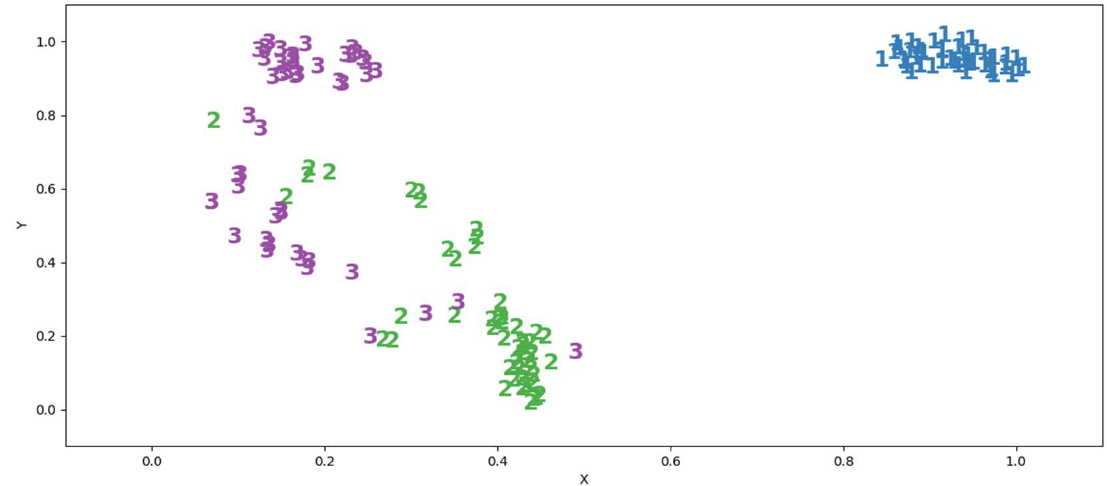
Figure 7. Fisher’s Irises training dataset (different classes colored differently for convenience). Table 5. SVM, VC and EnAE quality assessment by traditional criteria.